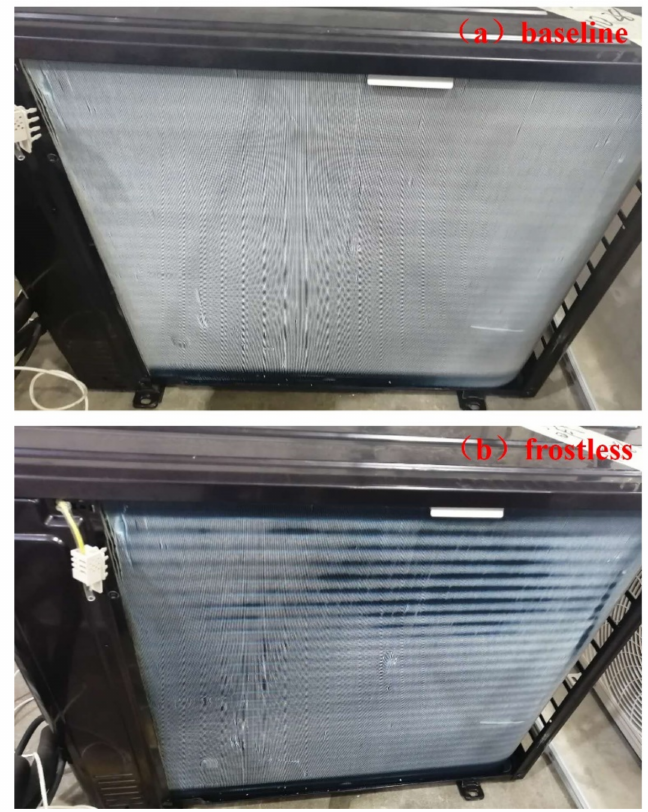
Figure 5. Frost on evaporator surface at 40th min in ( a ) baseline and ( b ) frostless